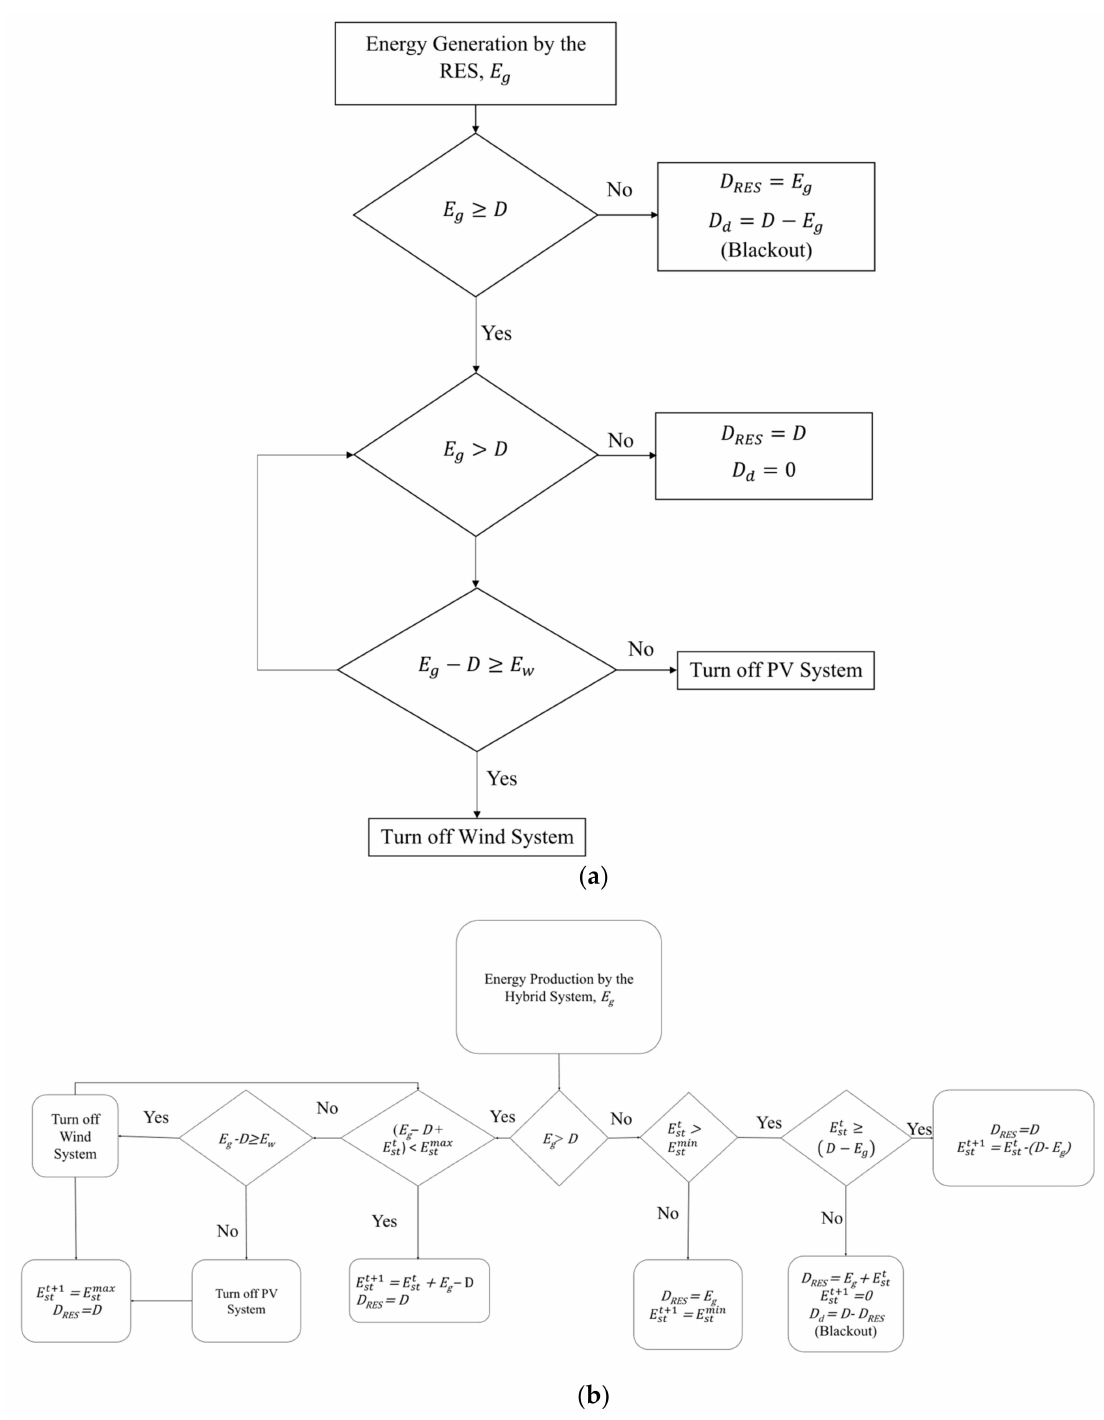
Figure 1. Energy flowchart of the photovoltaic (PV) / wind / hydro hybrid system: ( a ) Without an energy storage system (ESS) and ( b ) with